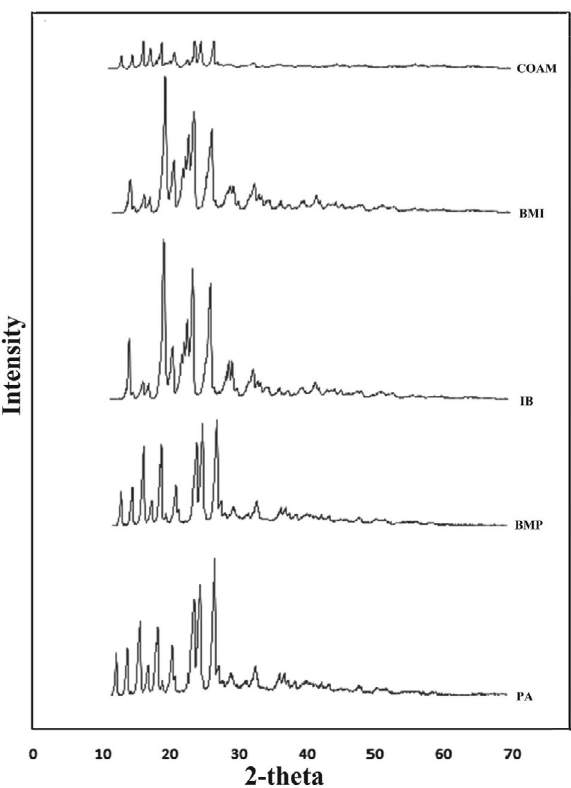
Figure 1. XRPD diffractogram of plain PA and IB, ball milled PA and IB, and COAM 1 samples